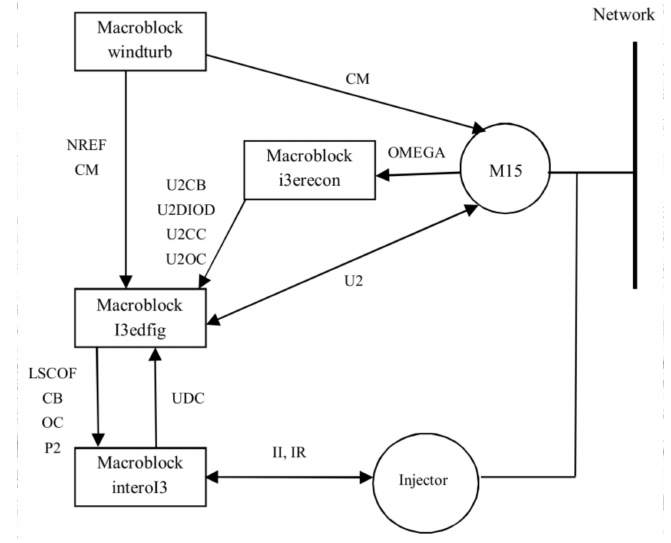
Figure 4. Scheme summarizing the